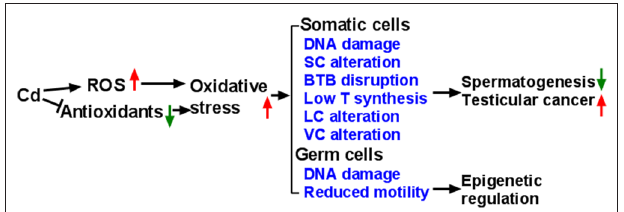
FIGURE 1 | Illustration of Mechanism of Cadmium (Cd) induces reactive oxygen species (ROS) generation and down-regulates endogenous antioxidants, thus leading to oxidative stress, which in turn causes abnormal development and function of testicular cells. Eventually, Cd exposure leads to abnormal spermatogenesis, testicular cancer, and damaged sperms. SC, Sertoli cell; BTB, blood-testis barrier; T, testosterone; LC, Leydig cell; VC, vascular